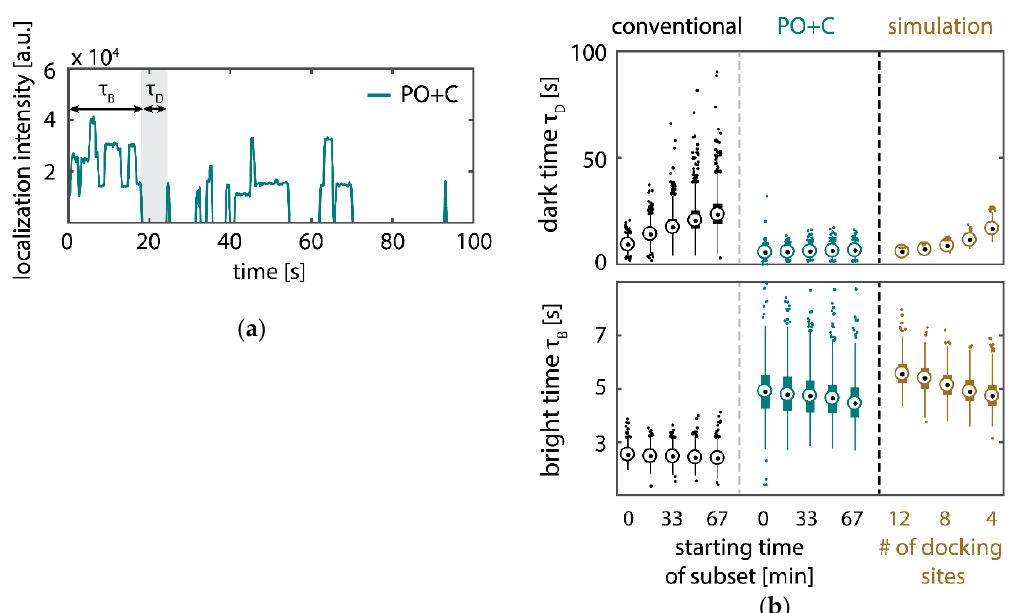
Figure A6. The number of available docking sites per origami structures influences the dark and bright times. ( a ) Intensity trace (representative section) of localizations assigned to the DNA origami presented in Figure 2 (PO+C) showing the effect of simultaneous binding. The step-wise increase corresponds to binding of imager strands, while the step-wise decrease indicates unbinding of an imager strand or photo-bleaching of individual fluorophores. ( b ) Comparison of experimentally obtained kinetics with simulations of origami nanostructures exposing a varying number of docking sites. On the one hand, a depletion of docking sites causes an increase in dark time τ D , as individual hybridization events are as probable, but the number of possible binding partners is reduced. On the other hand, the localization algorithm counts temporally overlapping binding events within one diffraction-limited spot as one longer binding event. The probability for simultaneous binding increases with the number of binding sites in one diffraction limited spot. For the simulation, we made the following assumptions, based on the results from SI-FCS measurements (see Table 1): association rate k a = 1.5 10 6 ( mol s ) − 1 , k d = 0.3 s − 1 , c = 10 nM and the number of binding sites decreasing step-wise with every subset from initially 12 to finally four binding sites. The simulated intensities from individual binding sites added up to obtain intensity traces for origami nanostructures